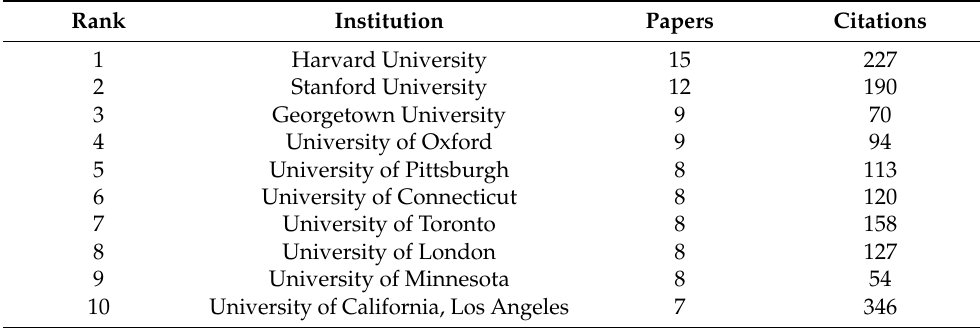
Table 4. Top 10 most influential